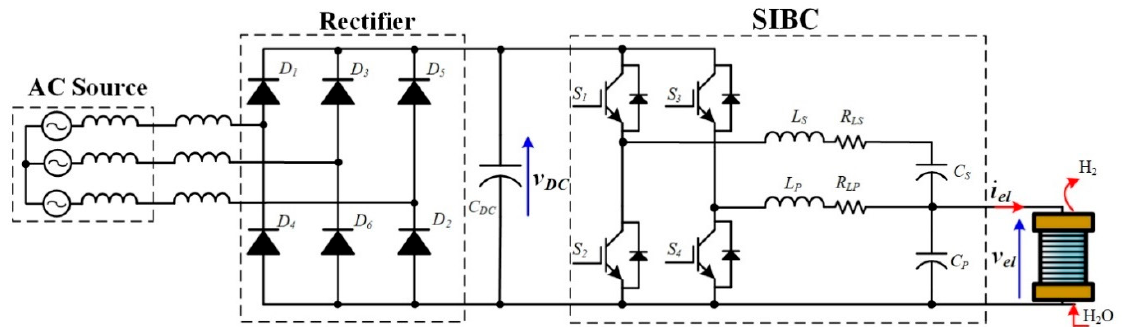
Figure 15. Six-pulse diode bridge rectifier with a two-phase stacked interleaved buck converter.